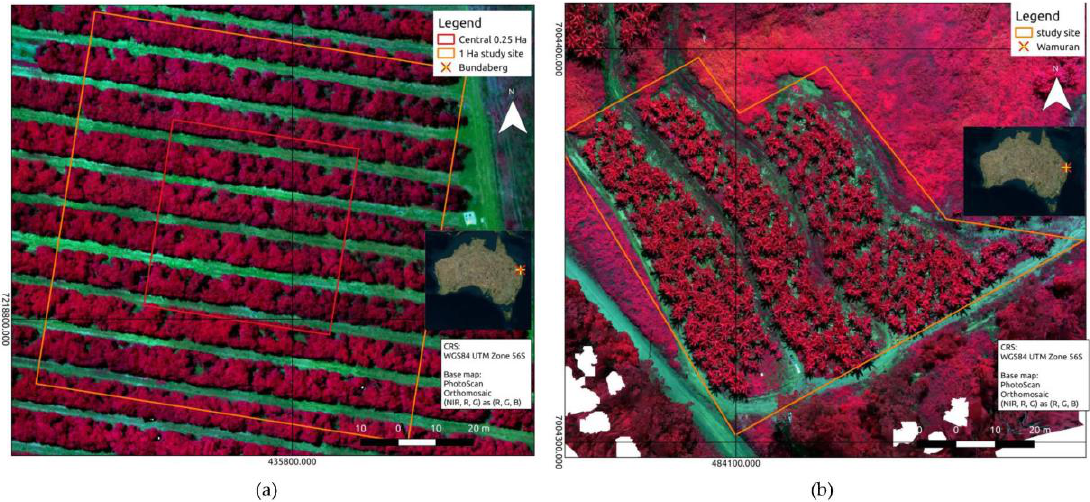
Figure 1. Study sites: ( a ) Avocado orchard in Bundaberg, ( b ) banana orchard in